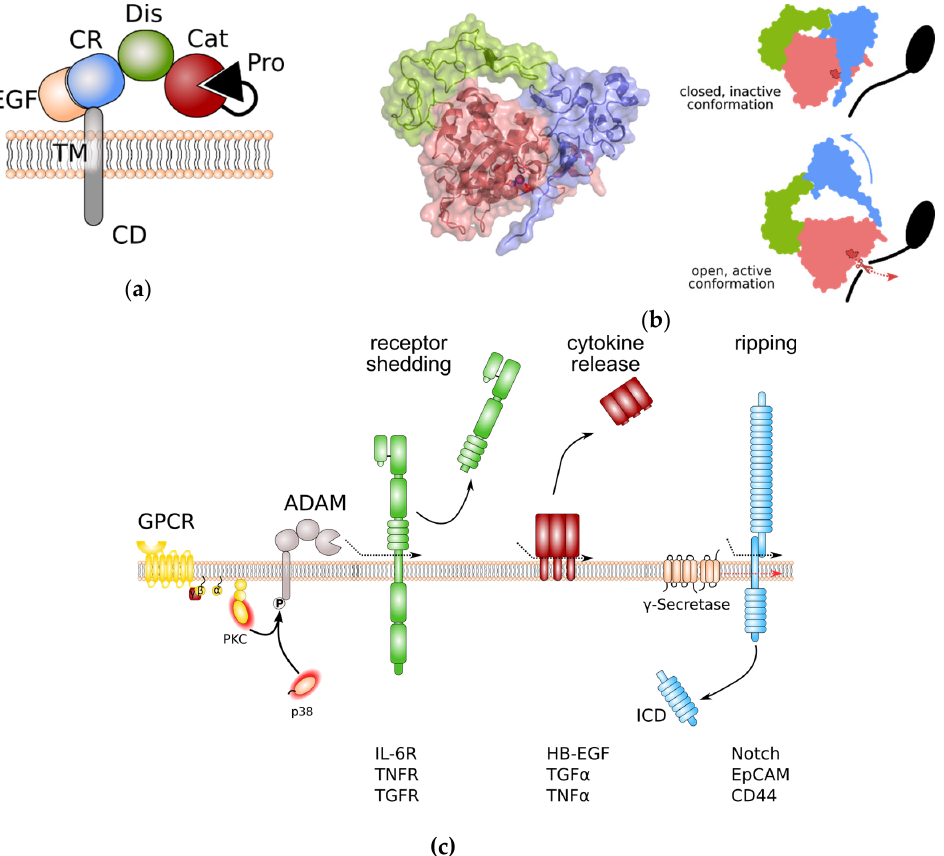
Figure 1. General structure of a disintegrin and metalloprotease (ADAM) proteases and overview of ADAM protease-induced pathways. ( a ) Domain structure of ADAM proteases. ( b ) Left panel: Crystal structure of the ADAM10 closed conformation, including the catalytic, disintegrin, and cysteine-rich domain. The Zn 2 + -binding motif is highlighted in dark red. Colouring of domains is as in ( a ). Note that the cysteine-rich domain prevents access to the catalytic site. Right panel: Anticipated movement of ADAM10 domains during activation. Colour coding as in ( a ). The Zn 2 + -binding motif of the catalytic site is indicated in dark red. ( c ) General signalling pathways regulated by ADAM proteases. Protein phosphorylation can regulate ADAM protease activity. Limited proteolysis by active ADAM proteases induces removal of receptor ectodomains, release of membrane-bound cytokines and growth factors, and initiates signal transduction by regulated intramembrane proteolysis (RIP). Removal receptor ectodomain can either blunt receptor signalling or induce so-called “trans-signalling” on neighbouring cells. EpCAM: epithelial cell adhesion molecule; EGF: epidermal growth factor; GPCR: G-protein coupled receptor; HB-EGF: heparin-binding EGF-like growth factor; ICD: intracellular domain; IL-6R: interleukin-6 receptor; PKC: protein kinase C; TNF α : tumour necrosis factor α ; TNFR: TNF α receptor; TGF α : transforming growth factor α ; TGFR: TGF β